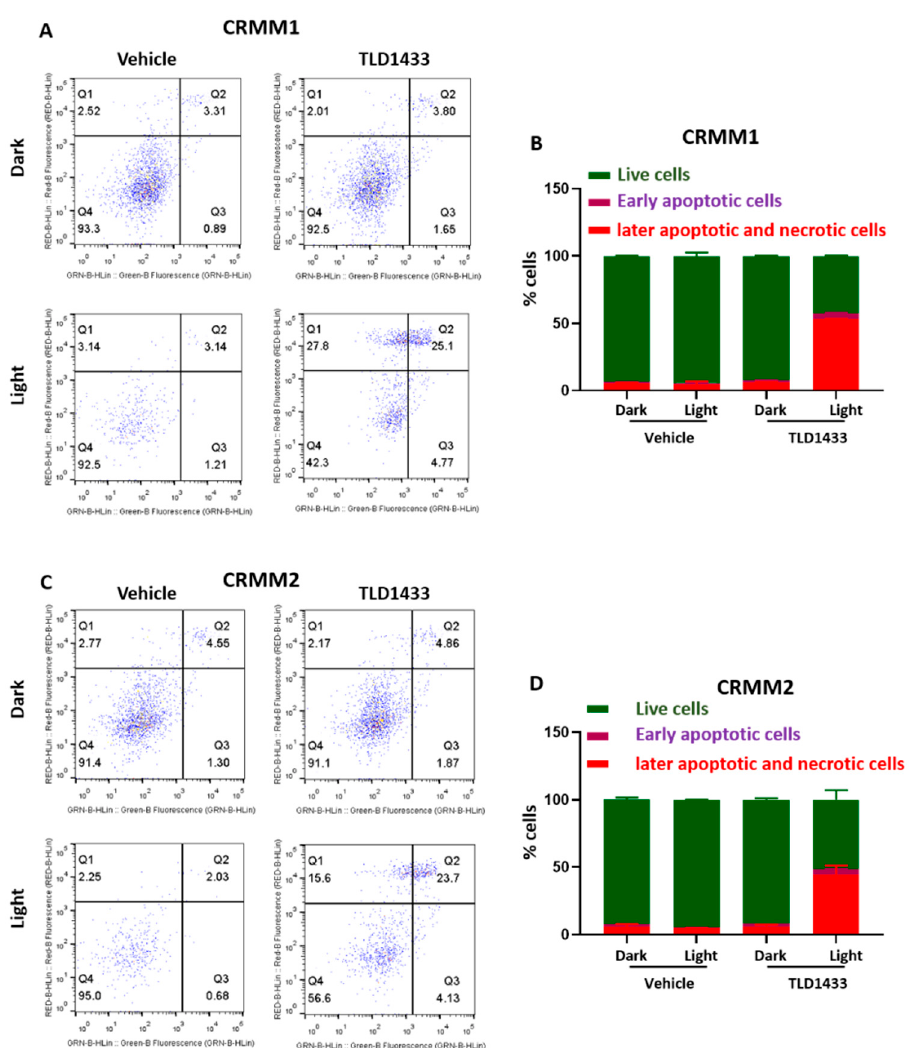
Figure 3. Green light irradiation of TLD1433 induces apoptosis and necrosis in CRMM1 and CRMM2 cells. ( A ) CRMM1 and ( C ) CRMM2 were stained with Annexin-V-FITC and Propidium Iodide. The percentages of live, early apoptotic, later apoptotic and necrotic cells in CRMM1 ( B ) and CRMM2 ( D